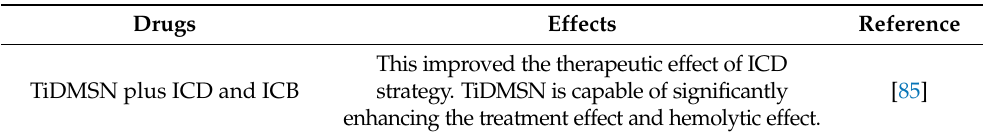
Table 4. Related drugs of nanotechnology combined with immunotherapy.